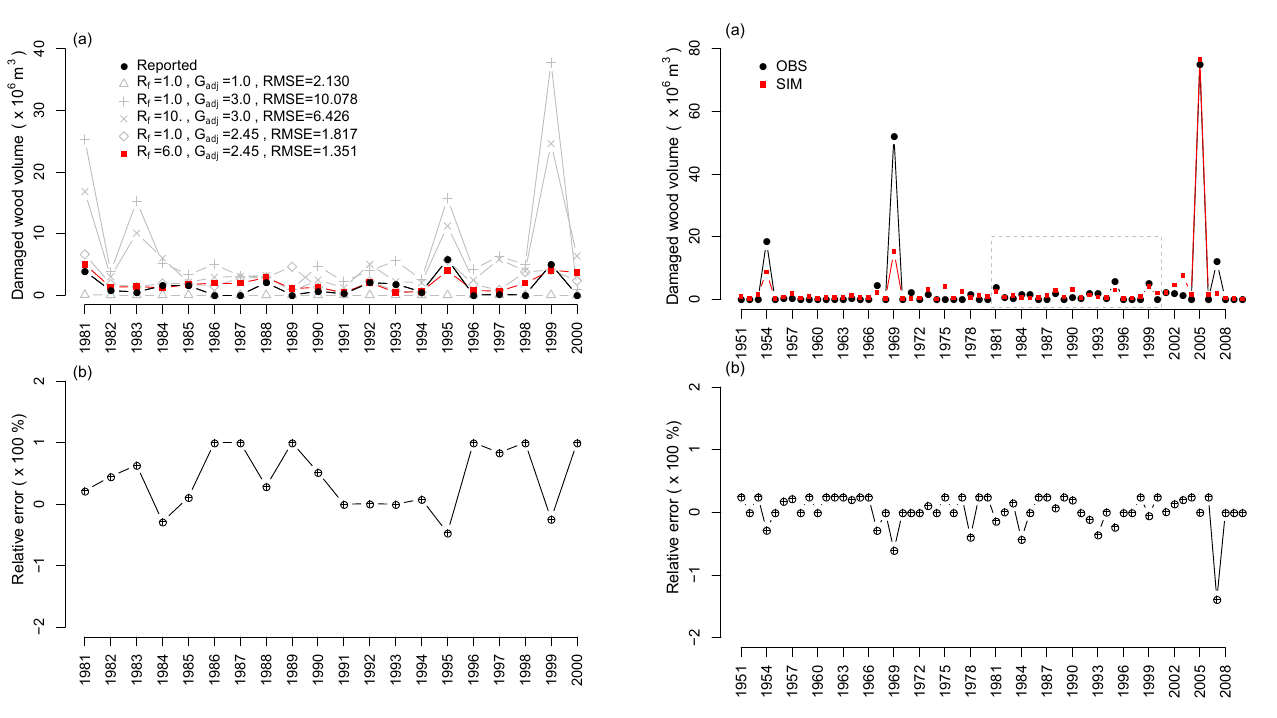
Figure 6. Comparison of the storm damage simulated by the ORCHIDEE-CAN and the reported wood damage over Sweden from 1951 to 2010. Observed storm damage is extracted from Nils- son et al. (2004), Schlyter et al. (2006), Bengtsson and Nilsson (2007), and Gardiner et al. (2010). The dashed-line area is the pe- riod from 1981 to 2000, which was selected for parameterization. The RMSE of the estimated storm damage is 1.35 × 10 6 m 3 for the parameterization period and 5.05 × 10 6 m 3 during the evalua- tion period. The validation period ranges from 1951 to 2010 but ex- cludes the years 1981 to 2000. The relative model simulation error for the validation period from 1981 to 2010 (b)